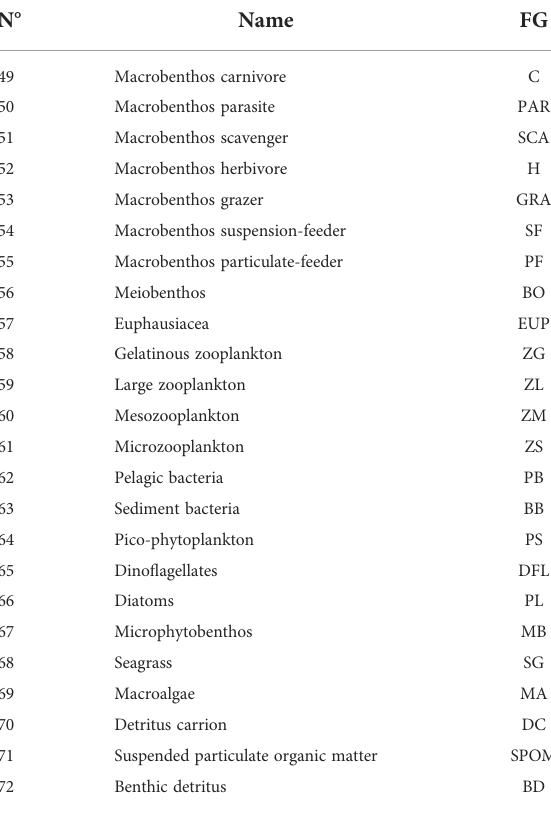
TABLE 1 Summary description of 72 biological functional groups